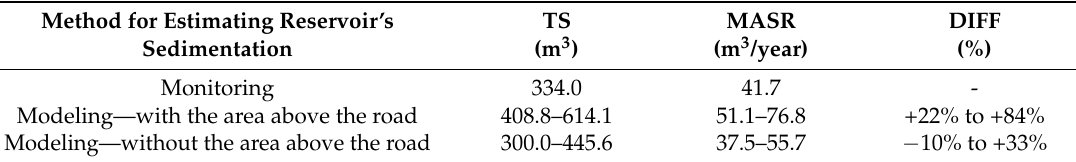
Table 2. Summary of the estimation of the mean annual sedimentation rate of the Vrbovce SWR as estimated by monitoring and modeling approaches. The two modeling approaches represent two scenarios with and without taking into account parts of the watershed above the III/1197 road